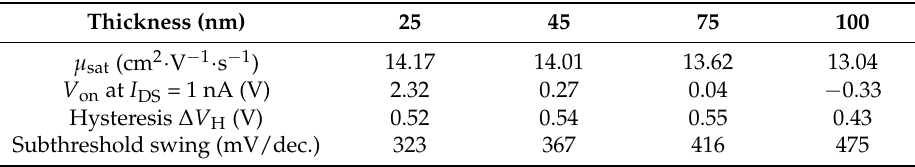
Figure 4. The initial transfer characteristics ( I DS – V GS ) of amorphous indium gallium zinc oxide (a-IGZO) TFTs with various T IGZO of ( a ) 25 nm; ( b ) 45 nm; ( c ) 75 nm; and ( d ) 100 nm measured at V DS of 0.1 and 20.1 V, respectively. Table 2. The electrical properties of a-IGZO TFTs with various T IGZO